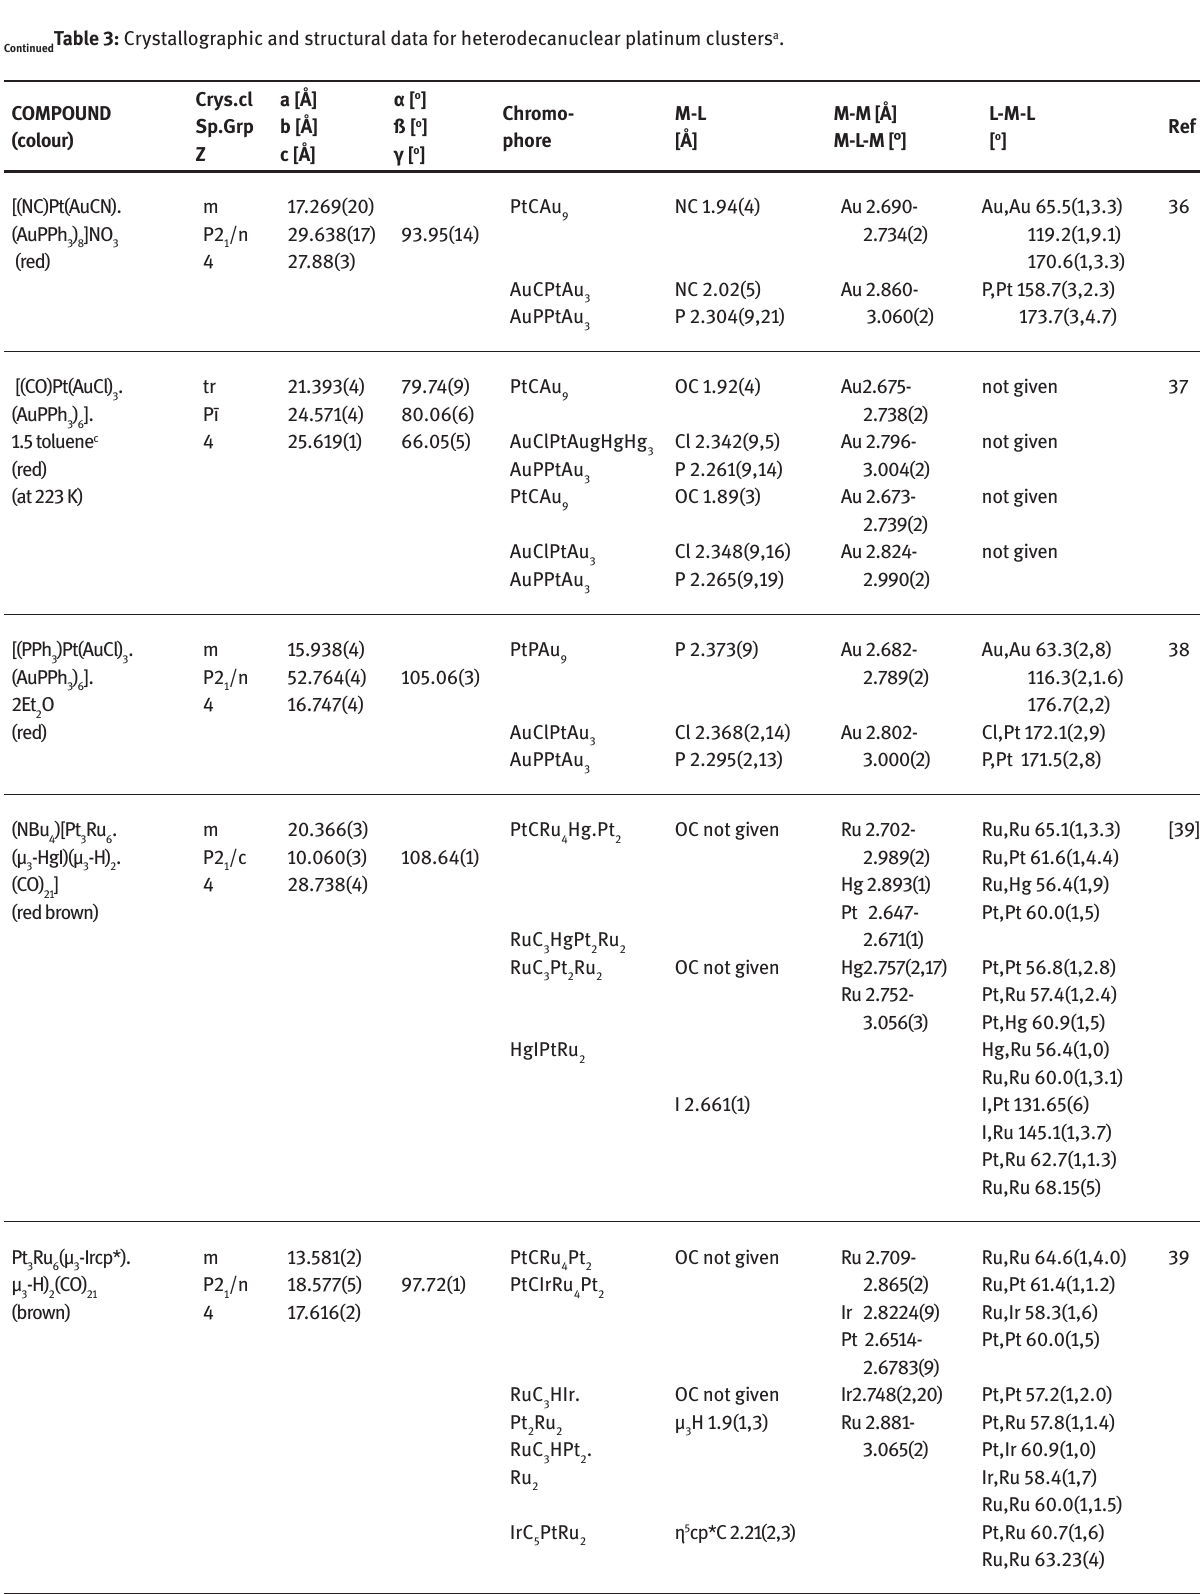
Table 3: Crystallographic and structural data for heterodecanuclear platinum clusters a Continued